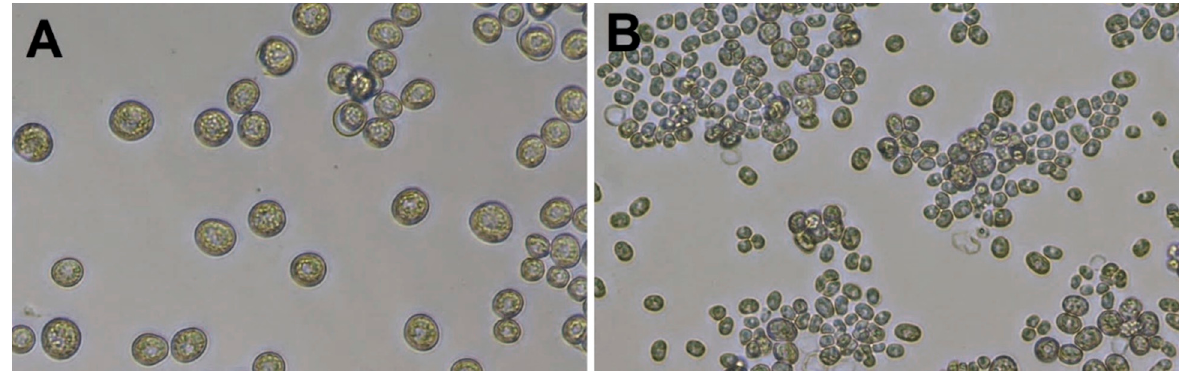
Figure 1. Cells of P. blaschkeae ( A ) and P. bovis ( B ) microalgae strains grown in RPMI 1640 medium. Images were taken at 200× magnification using a Leica DM IL LED Microscope (Leica Microsystems CMS GmbH, Wetzlar, Germany).